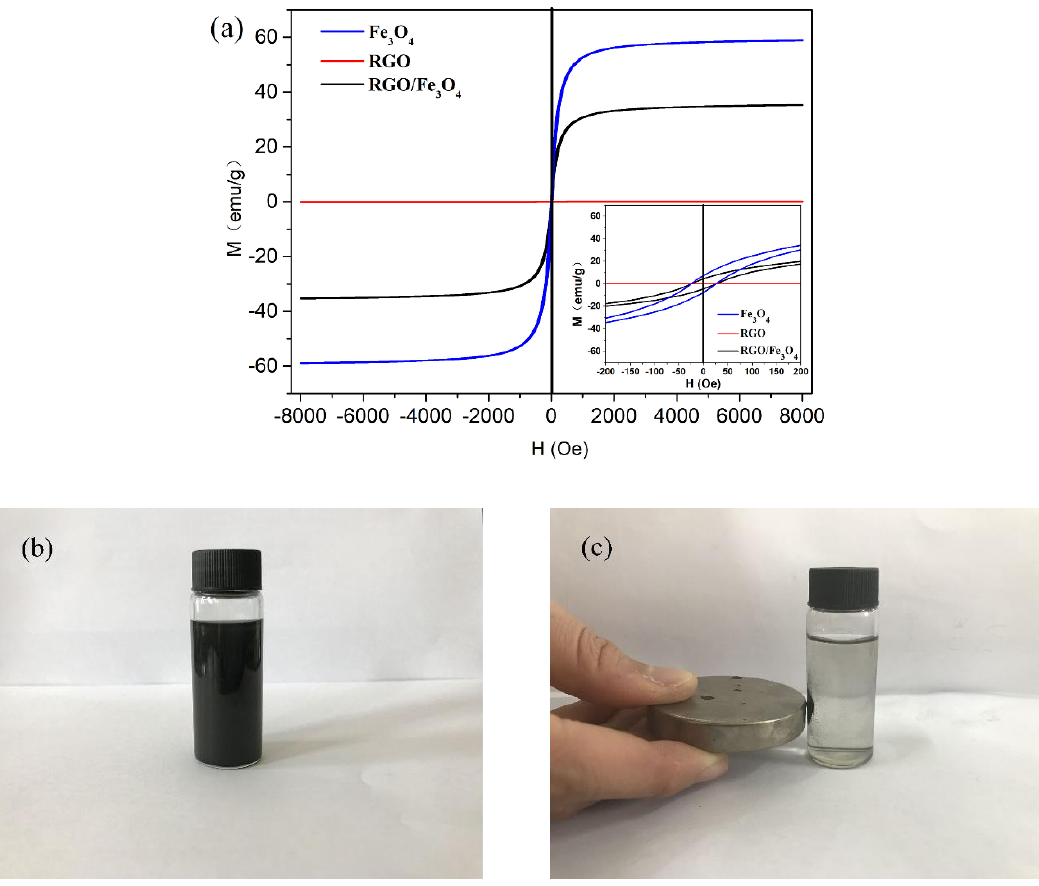
Figure 3. ( a ) Hysteresis loops of different samples measured at 298 K, ( b ) RGO/Fe 3 O 4 nanocomposites dispersed in alcohol, and ( c ) separated by a magnet.